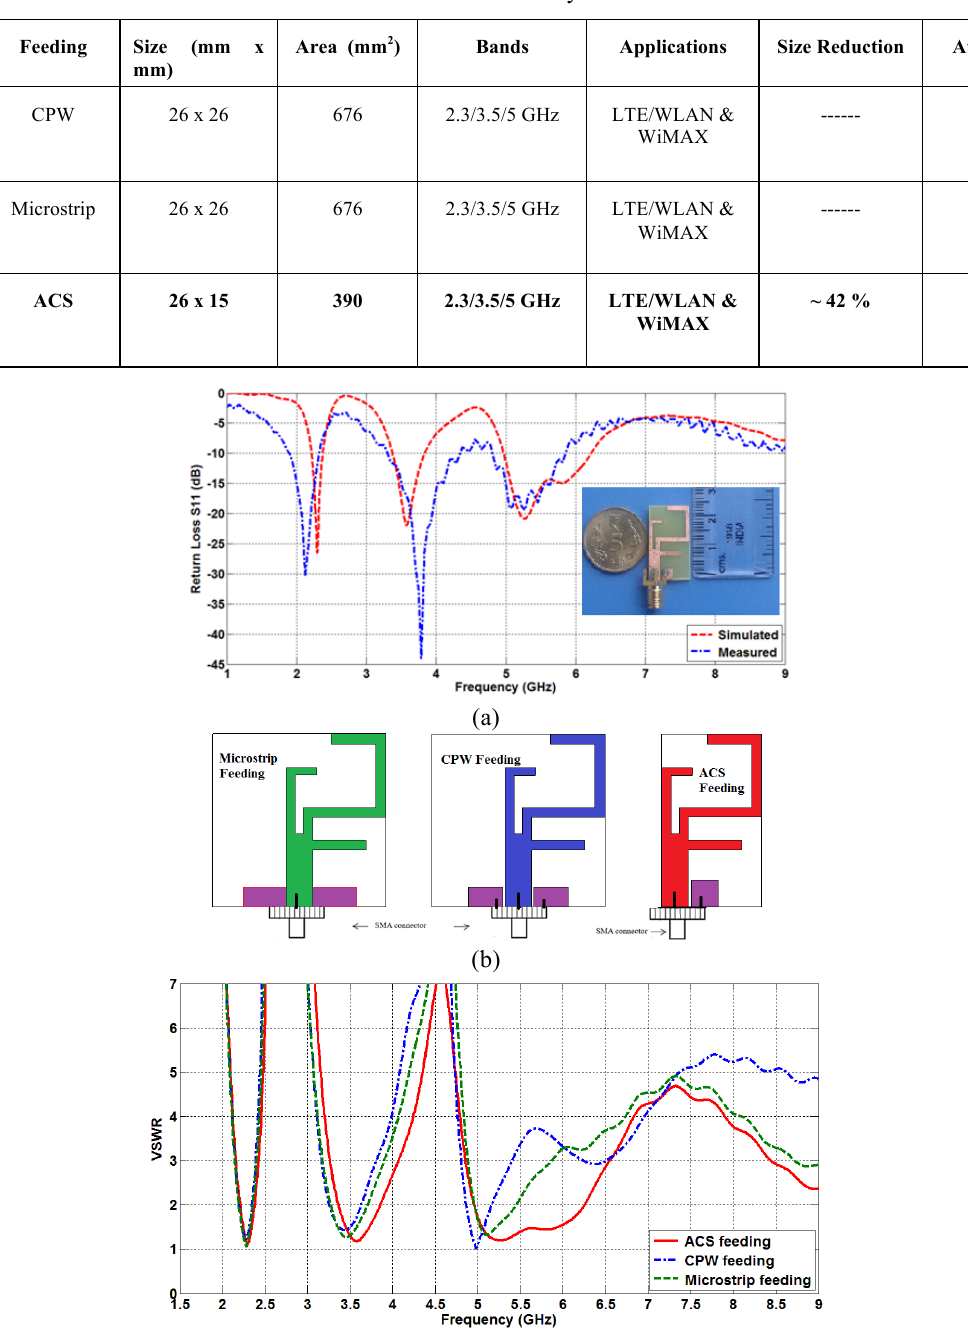
Figure 6: (a) Experimental results with prototype (b) Feeding configurations (c) VSWR